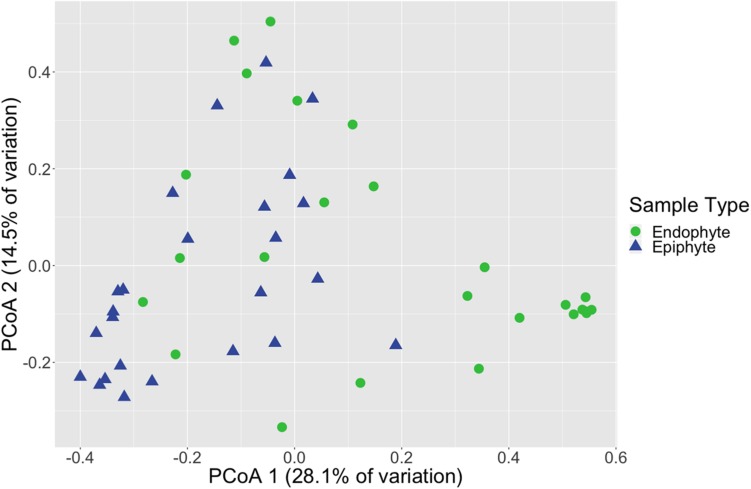
Leaf fungal community structure varies between epiphytes and endophytes. Principal coordinates analysis (PCoA) visualization of Bray-Curtis dissimilarities of fungal communities associated with leaves. Points in the ordination are colored and represented by shapes based on epiphyte (blue triangles; n = 25) or endophyte (green circles; n = 25) status. The dataset was first subset to a depth of 5,000 ITS2 amplicon sequences per sample and then Bray-Curtis dissimilarities were calculated using the ordinate function in phyloseq (McMurdie and Holmes, 2013).